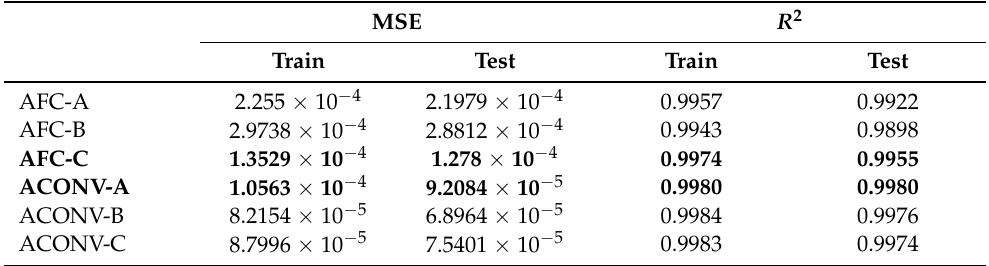
Table 8. Stacked autoencoder results for the dataset 4. The boldface indicates the best results. MSE R 2 Train Test Train Test AFC-A 2.255 × 10 −